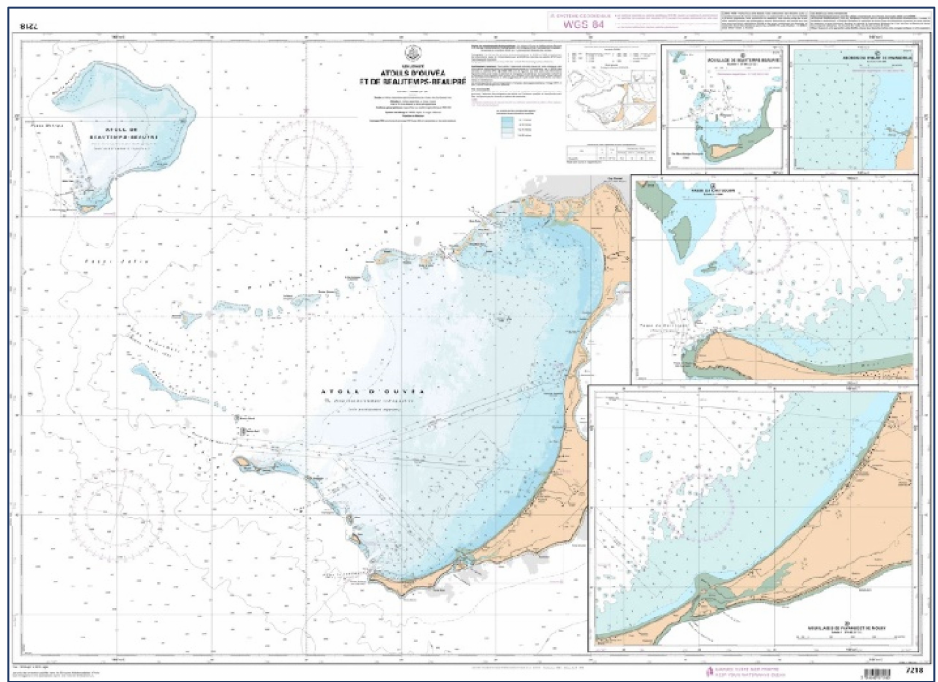
Figure 1. An ageless reference: the first satellite-based nautical chart ever produced by a Governmen-